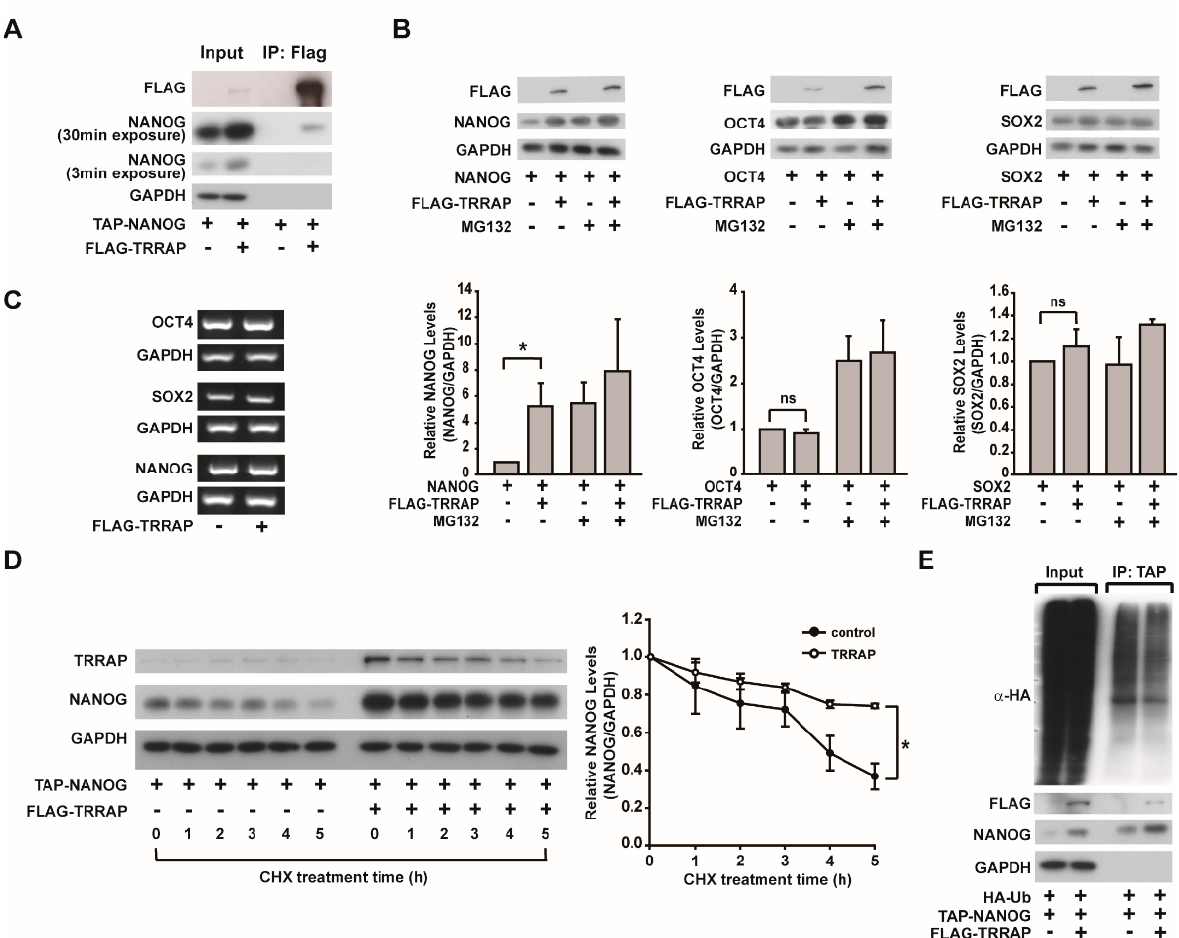
Figure 1. Identification of TRRAP as a NANOG-binding protein that affects NANOG stability. ( A ) Co-immunoprecipitation of NANOG and TRRAP in HEK293 cells. HEK293 cells were transfected with TAP-NANOG or FLAG-TRRAP, the cell lysates were incubated with streptavidin beads to precipitate TAP-NANOG, and the protein levels of GAPDH, NANOG, and TRRAP were analyzed via Western blotting analysis. ( B ) TRRAP-mediated increase in NANOG protein. TRRAP, OCT4, SOX2, and NANOG were overexpressed in HEK293 cells, which were then treated with MG132 for 4 h. Protein levels were analyzed via Western blot analysis. The protein levels of OCT4, SOX, and NANOG were quantified and normalized with that of GAPDH. Data are expressed as the mean ± SD ( n = 3, lower panel). * indicates p < 0.05 by Student’s t -test. ns stands for not significant. ( C ) The effects of TRRAP overexpression on the mRNA levels of OCT4 , SOX2 , and NANOG . HEK293 cells were transfected with TRRAP, OCT4, SOX2, and NANOG, and their mRNA levels were analyzed via RT-PCR. ( D ) The effects of TRRAP overexpression on the protein stability of NANOG. HEK293 cells were transfected with plasmids bearing TAP-NANOG and FLAG-TRRAP, treated with cycloheximide (CHX) for the indicated times, and the protein levels of TRRAP and NANOG were determined via Western blotting. The protein levels of NANOG were quantified and normalized with that of GAPDH ( n = 3, right panel). * indicates p < 0.05 by Student’s t -test. ( E ) The effects of TRRAP overexpression on the ubiquitination of NANOG. HEK293 cells were transfected with plasmids bearing TAP-NANOG, FLAG-TRRAP, and HA-Ub, and treated with 20 µ M MG132 for 4h, followed by the precipitation of TAP-NANOG with streptavidin beads. (Left panel) The protein and ubiquitination levels of NANOG were determined via Western blotting using anti-NANOG and anti-HA antibodies, respectively. (Right panel) Quantification of the relative levels of ubiquitinated NANOG per NANOG protein.